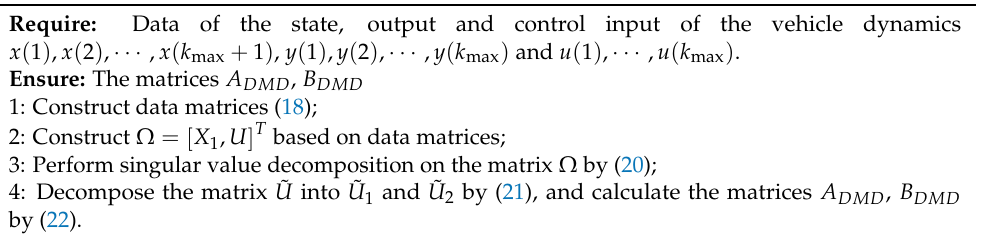
Algorithm 2 Approximation of Koopman operator with DMDc